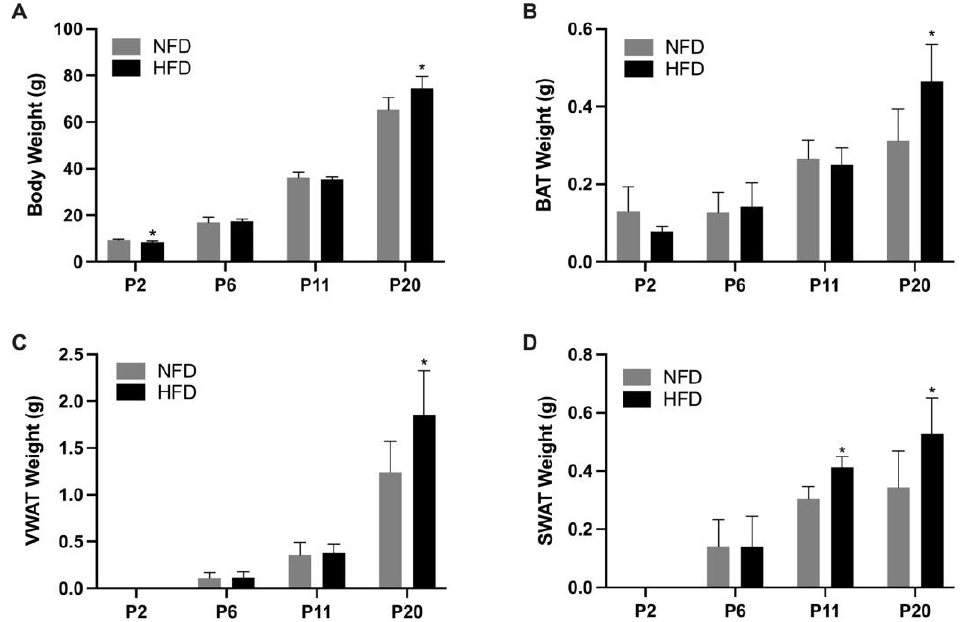
Figure 3. Body weight ( A ), brown adipose tissue weight ( B ), visceral white adipose tissue weight ( C ), and subcutaneous white adipose tissue weight ( D ) of rat pups at postnatal day 2, postnatal day 6, postnatal day 11, and postnatal day 20. Bars show mean ± SD, n = 7 per group. Significant difference between groups was indicated by *, p < 0.05. At P2, visceral white adipose tissue and subcutaneous white adipose tissue samples were not adequate for analysis, and therefore, data are missing.